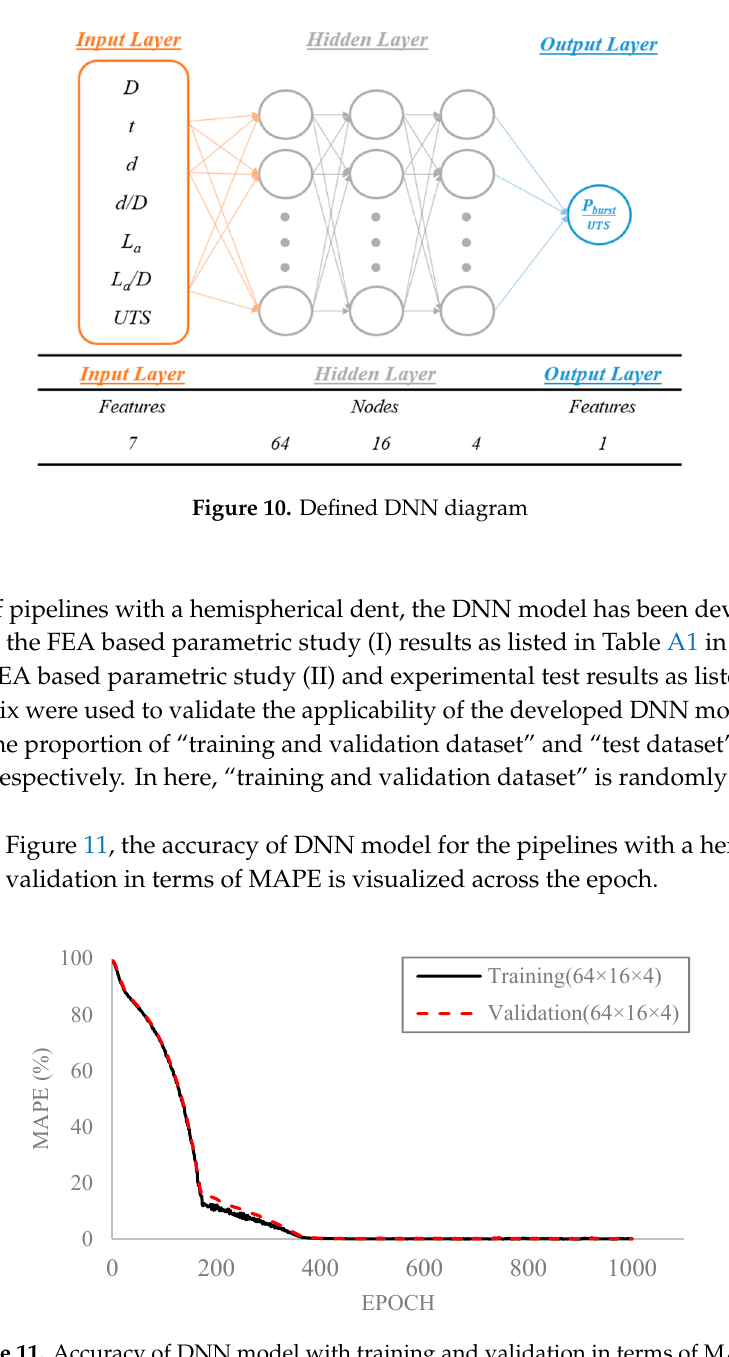
Table 6. Summary of the defined hyper ‐ parameters for deep neural network model.